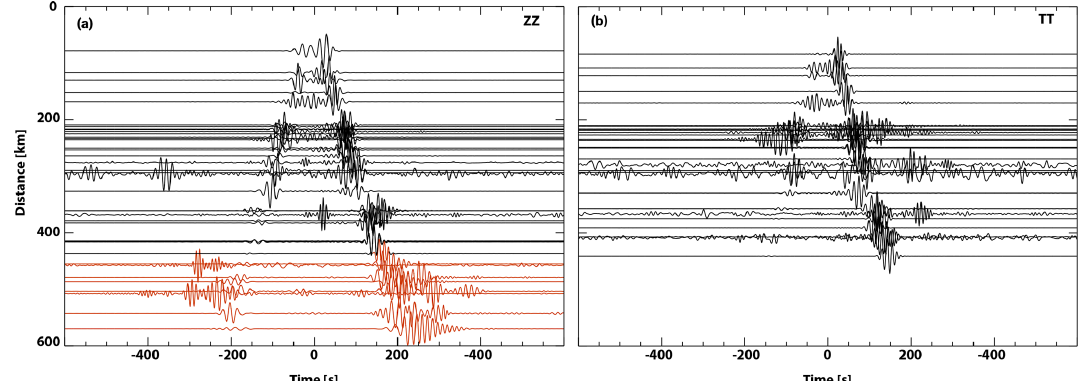
Figure 3. Record section of Guiana Shield station CMPC (see Fig. 1). Specifically, we show the non-symmetric, stacked EGFs between CMPC and all of the rest of the stations. (a) Vertical–vertical (Z–Z) component where EGFs from CMPC–land stations are shown as black lines and EGFs from CMPC to OBSs as red lines. (b) Same as (a) , but for the transverse–transverse (T–T) component